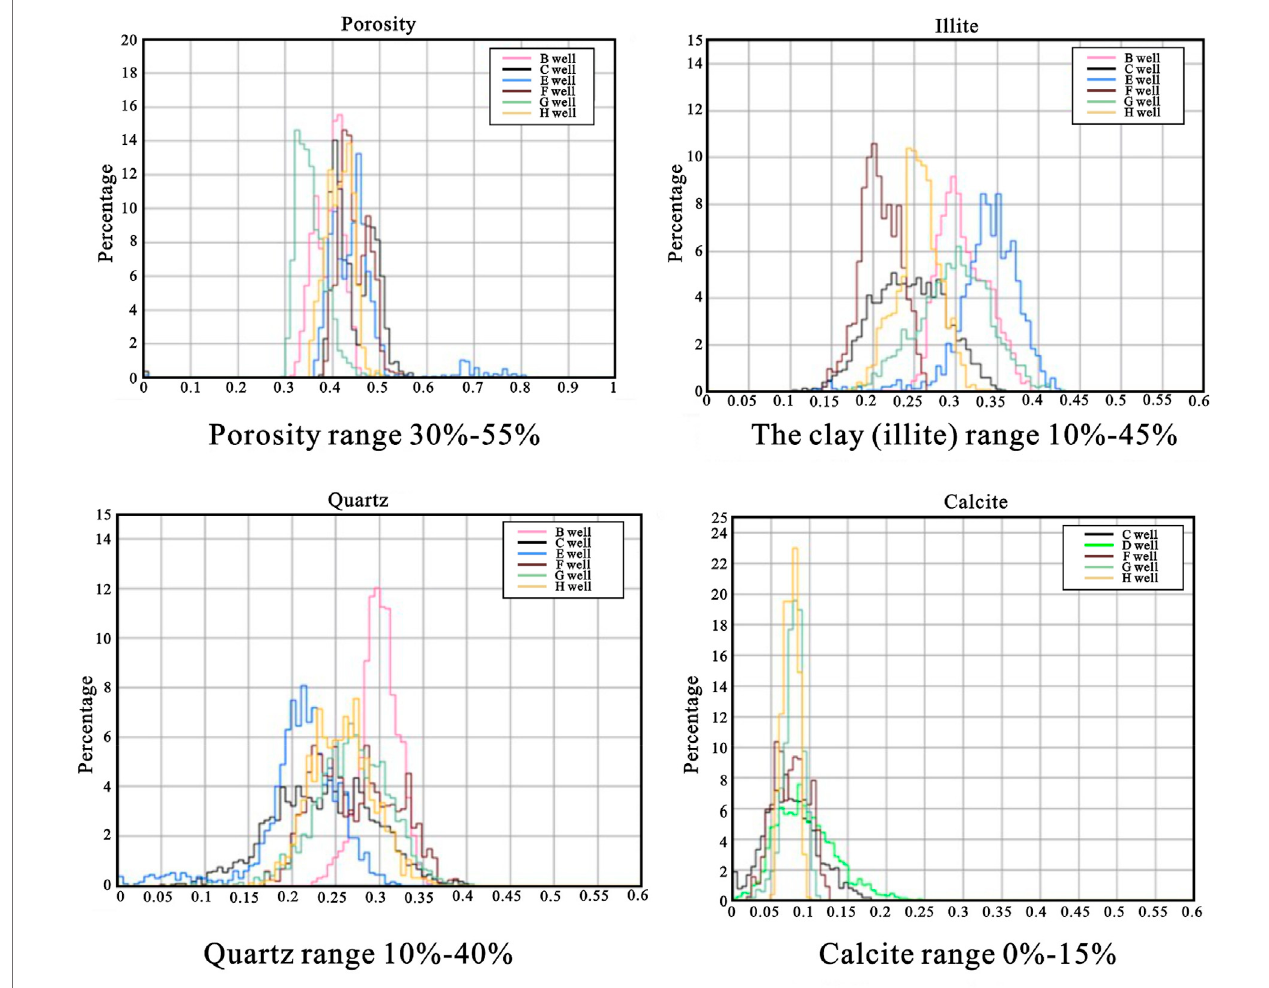
FIGURE 6 | Histogram of mineral composition and porosity distribution of multiple Wells in the study area.